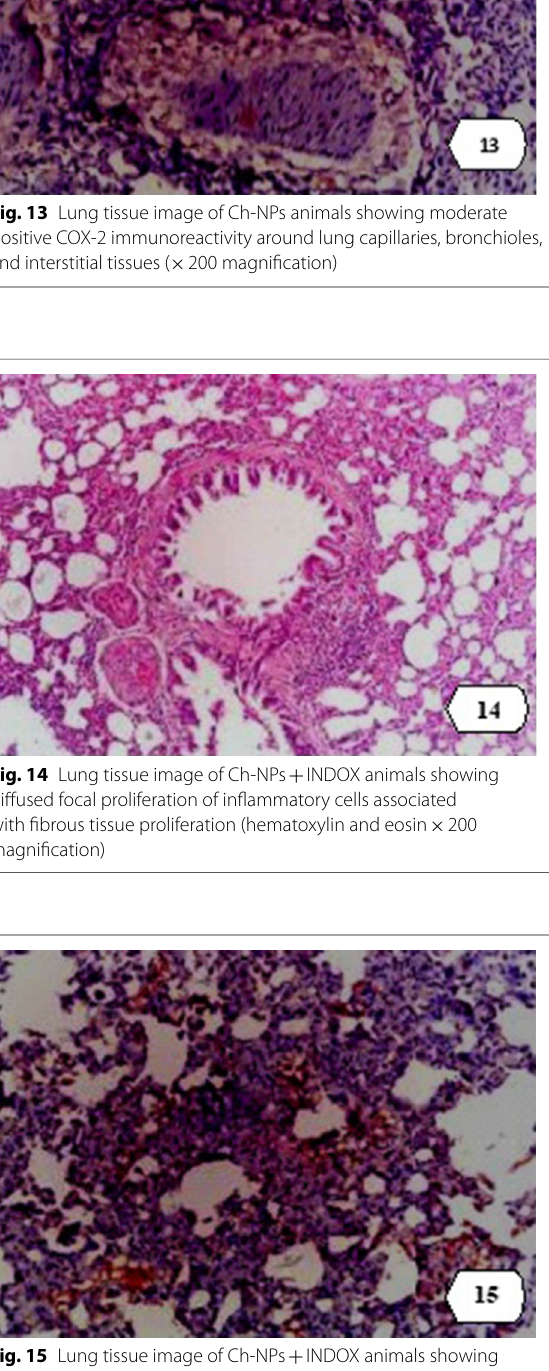
INDOX animals showing + 200 ×